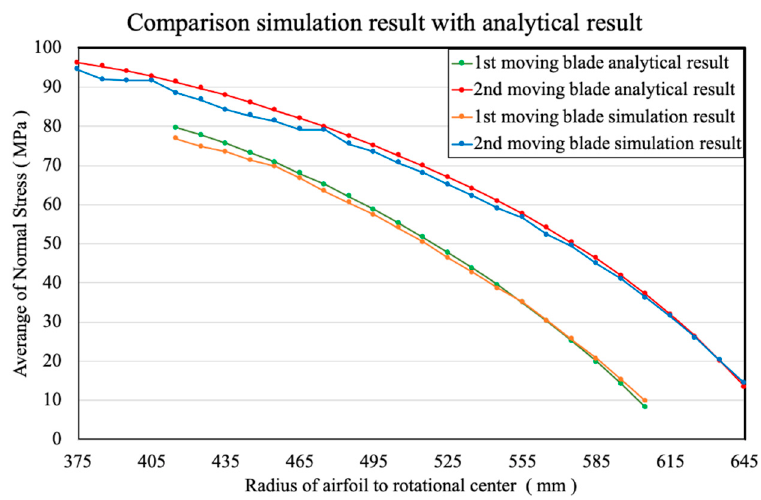
Figure 13. Comparison diagram of analytic solution and simulation of centrifugal stress on TRT blade.